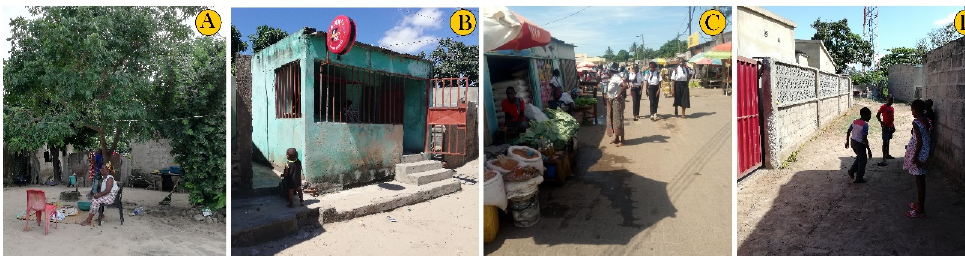
Figure 6. Informal trade integrated into the fences of dwellings (source: created by the authors based on Salamagy and Alves [23]). Legend: ( A )—house backyard; ( B )—kiosks as an integral part of fences; ( C )—a wide street, prime space for circulation, socialising, meeting and local commerce; ( D )—the street as a public space for entertainment.